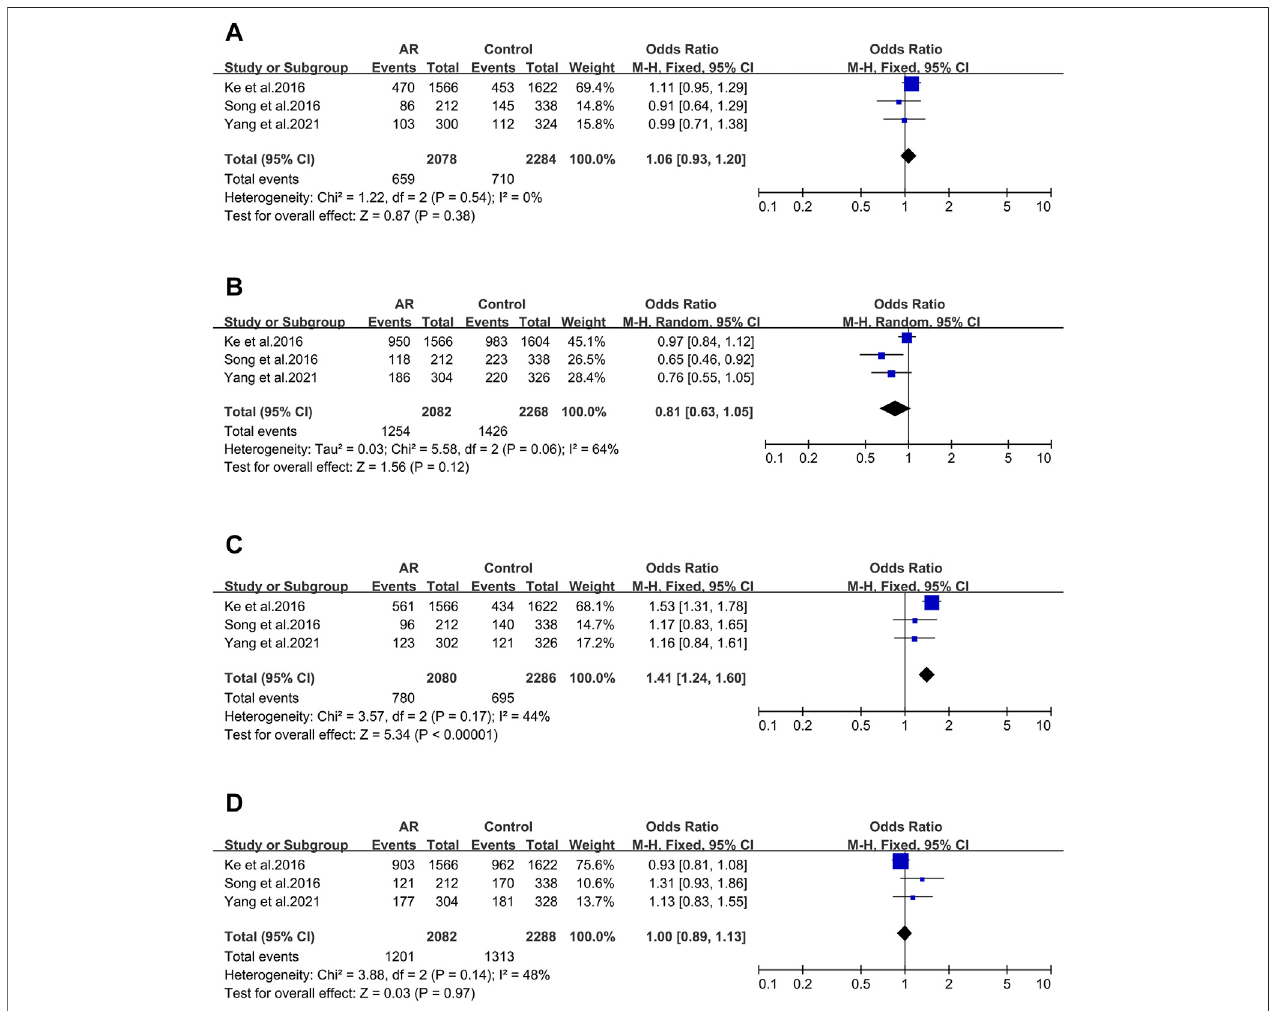
FIGURE 3 | Forest plots for CTLA-4 polymorphism. (A) CTLA-4 (rs3087243); (B) CTLA-4 (rs231725); (D) CTLA-4 (rs11571302); (D) CTLA-4 (rs11571315).